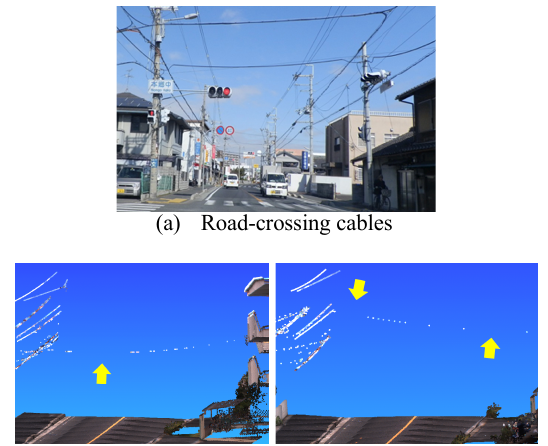
Figure 2. Points-clouds on road-crossing cables